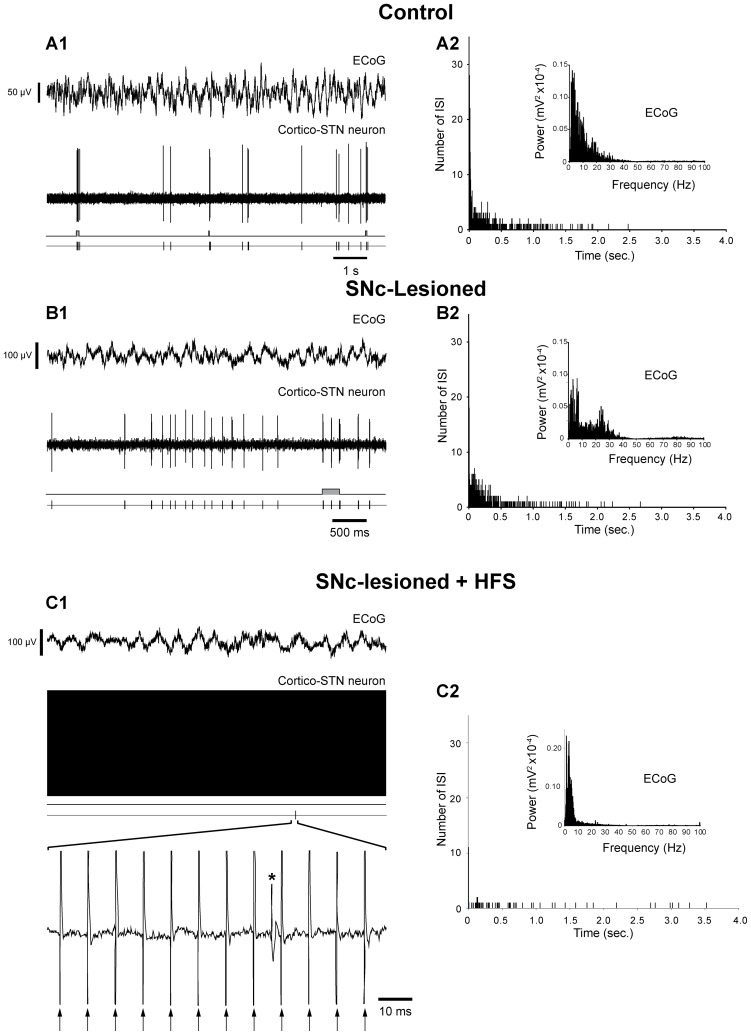
Effect of SNc lesion and impact of STN HFS on the spontaneous activity of cortico-STN cells and on the electrocorticogram (ECoG) of the orofacial motor cortex.The spontaneous activity of a cortico-STN neuron was extracellularly recorded simultaneously with the ECoG signal of the orofacial cortex in control rats (A), and in SNc-lesioned animals, before (B) and during STN HFS (C). Note that the SNc lesion induces an increased firing rate of the cortico-STN neuron (B1) that is accompanied by an increased number of bursts and by the appearance of an excessive synchronization in beta frequency band in the ECoG (B2, inset) compared to control situation (A1, A2, inset). These SNc lesions-induced changes were abolished during STN HFS (C). In panels A1
,
B1, and C1, the different traces correspond, from the top to the bottom, to the ECoG signal, the simultaneous extracellular recording of the cortico-STN cell, the bursting discharge detected by Poisson Surprise analysis (S≤2) and the discharge of the cell represented as a sequence of spikes. In panels A2
,
B2, and C2, histograms display the corresponding interspike intervals and insets show the power spectrum (FFT) of the corresponding ECoGs. In C1, arrows indicate the stimulation artifacts and the asterisk an action potential. Abbreviation: ECoG: electrocorticogram; FFT: Fast Fourier Transform; HFS: high-frequency stimulation; ISI: interspike interval; SNc: substantia nigra pars compacta; STN: subthalamic nucleus.